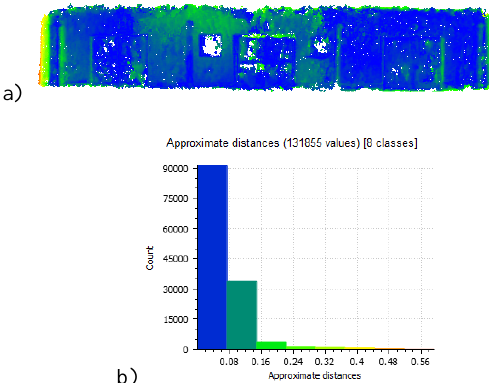
Figure 13. Accuracy assessment of a point cloud generated from video frames with a 85% overlap, with reference to TLS data a) in graphical form and b) as a plot